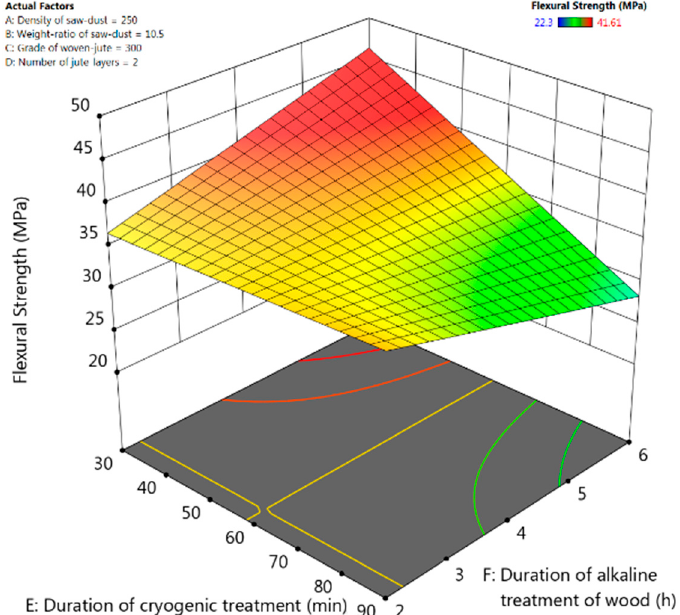
Figure 6. Response-surface plots for flexural strength for interactive effect between the duration of alkaline treatment and the duration of cryogenic treatment of composite.